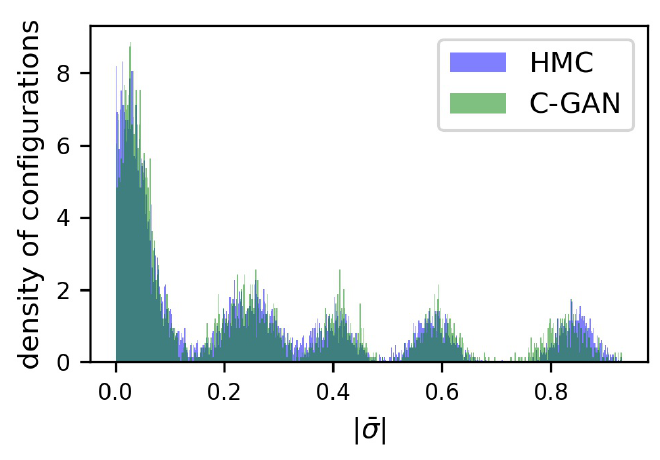
Figure 3: Histogram of | ¯ σ | for λ C-GAN.